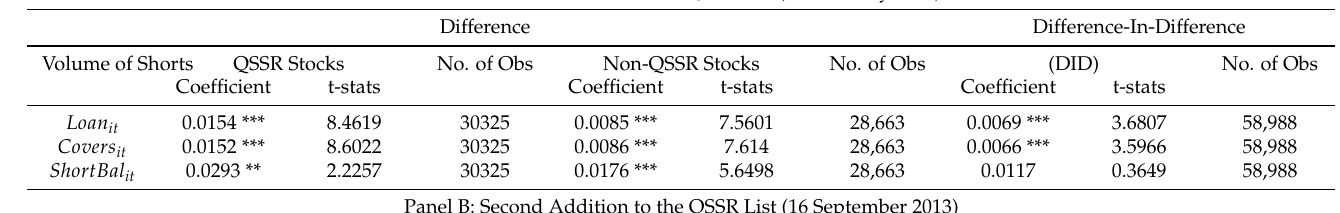
Refinancing (QSSR)